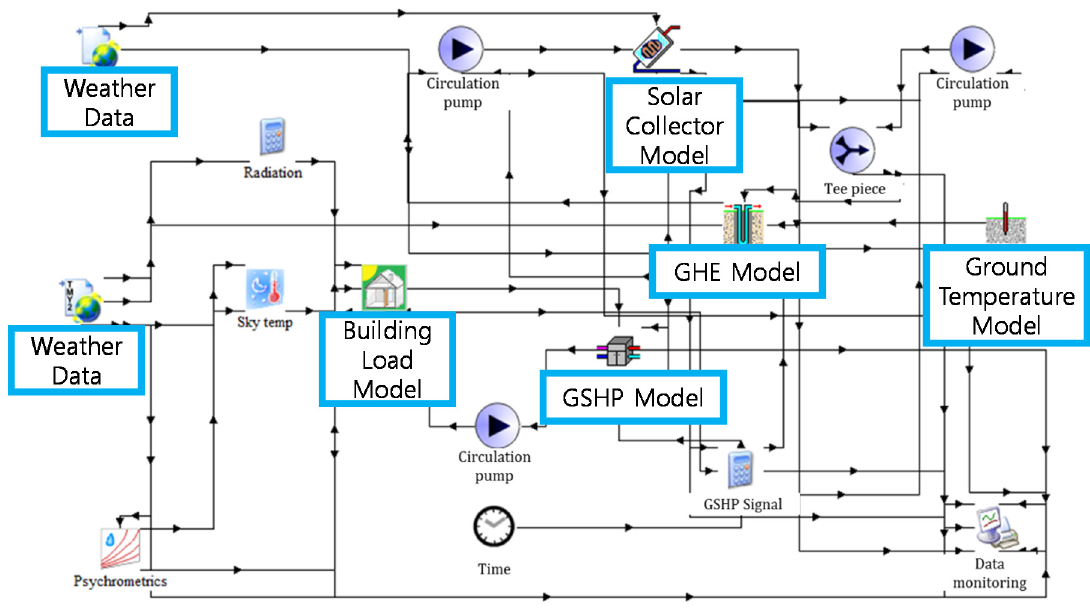
Figure 3. Performance prediction model.